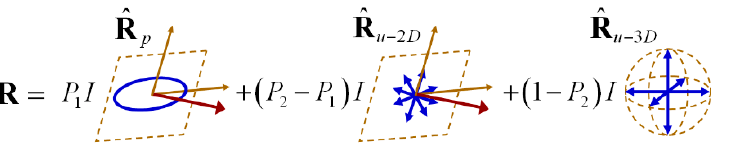
Figure 6. Characteristic decomposition of a regular genuine 3D state. The discriminating component is a 2D unpolarized state ˆ R u − 2 D whose polarization plane coincides with that of the pure component ˆ R pO and the 3D unpolarized state has nonzero contribution [20].